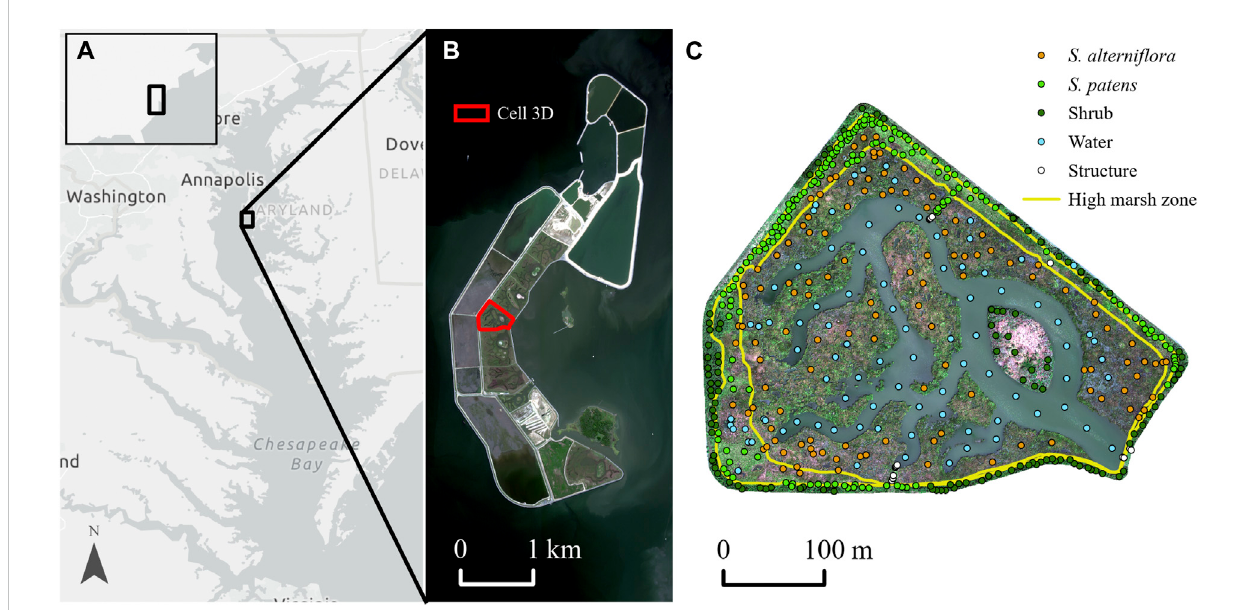
FIGURE 1 Overview of the study site location. (A) Location of Poplar Island in the Chesapeake Bay, Maryland, United States (B) WorldView-2 satellite image captured on 15 September 2020 of the Paul S. Sarbanes Ecosystem Restoration Project at Poplar Island with Cell 3D outlined in red (C) UAS RGB compositeofCell3Dcollectedon26August2020overlaidwiththeas-builtplantingboundariesofhighandlowmarshinyellowand fi eldvalidation data used to train the random forest classi fi